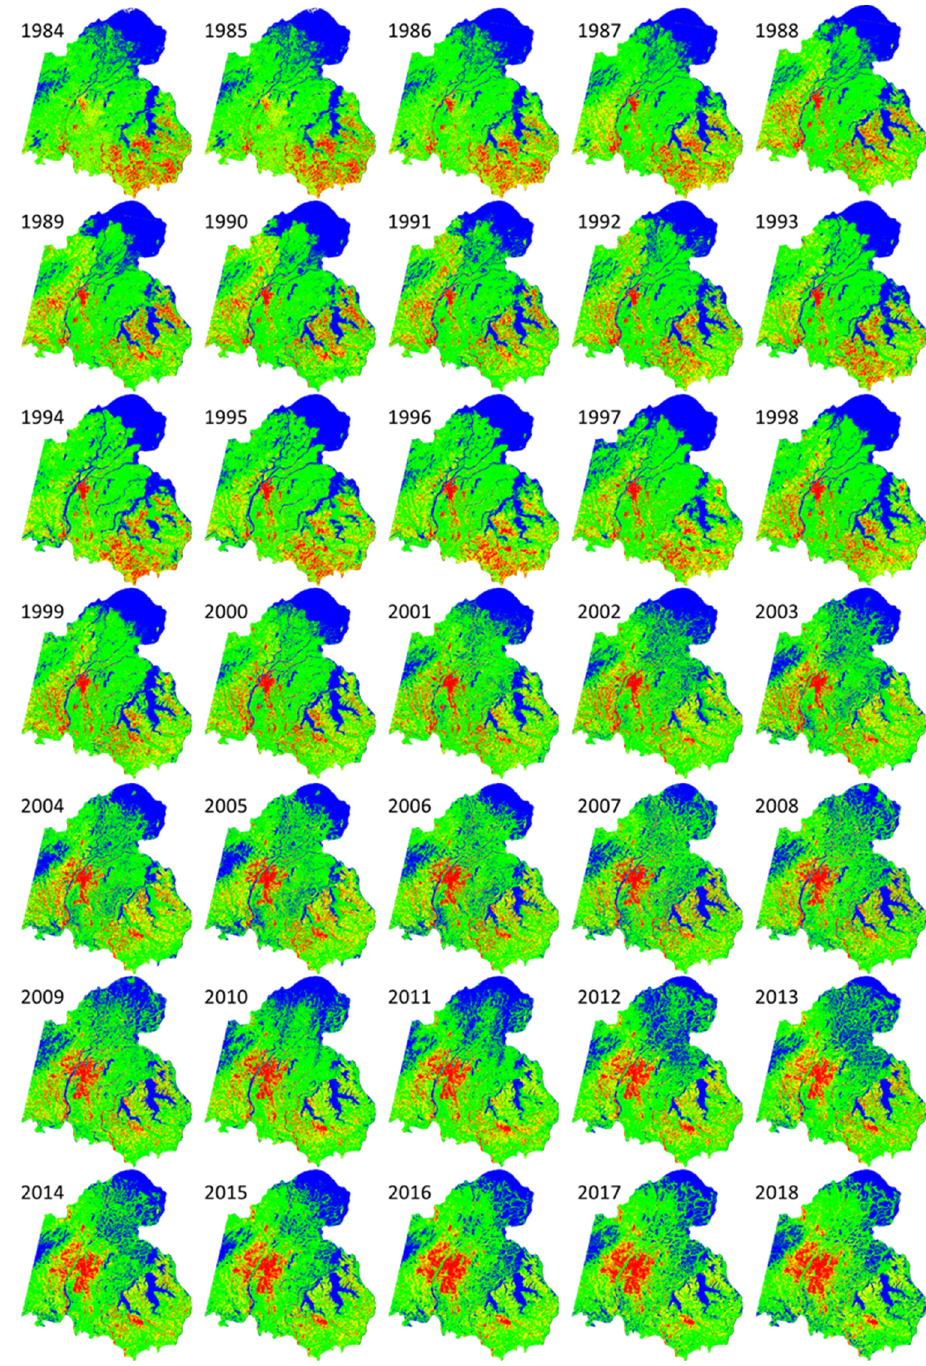
Figure 9. SUHI distribution in Nanchang from 1984 to 2018. For each image, the red area is the top 7.5% LST, the yellow area is the top 7.5–25% LST, the green area is the top 25–80% LST and the blue area is the last 20% LST.